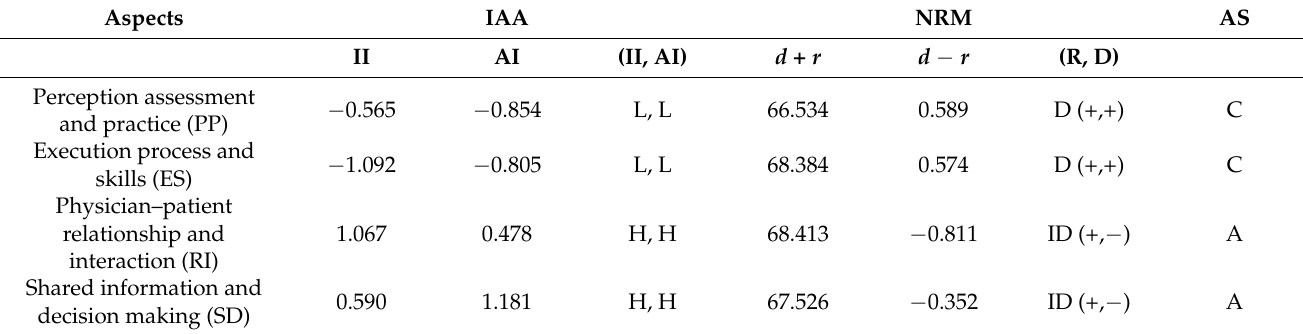
Table 3. The adoption strategy of SDM competency development.